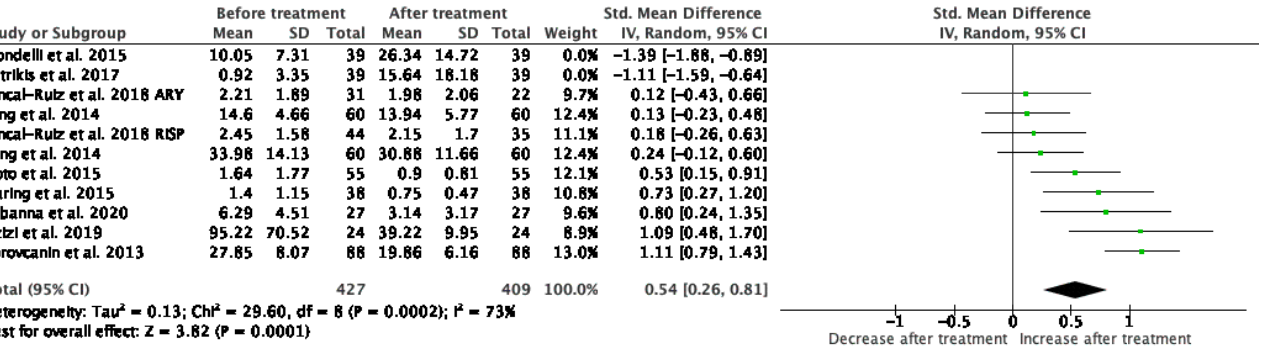
Figure 7. Meta-analysis of IFN- γ .